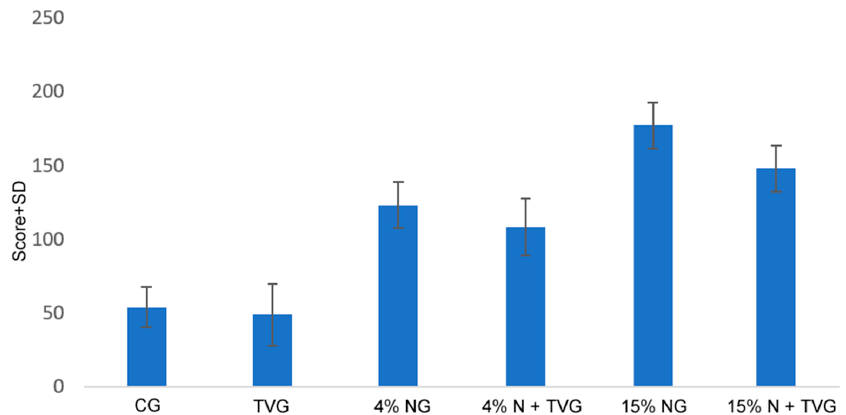
Figure 7. Analysis of the groups in the study with H-score. This difference between the groups was statistically significant between CG and 4% NG, TVG and 4% NG, CG and 15% NG, TVG and 15% NG, 4% NG and 4% N + TVG, and 15% NG and 15% N + TVG (Table 4). Table 4. Statistical analysis of H-scoring between groups. Mean Comparison